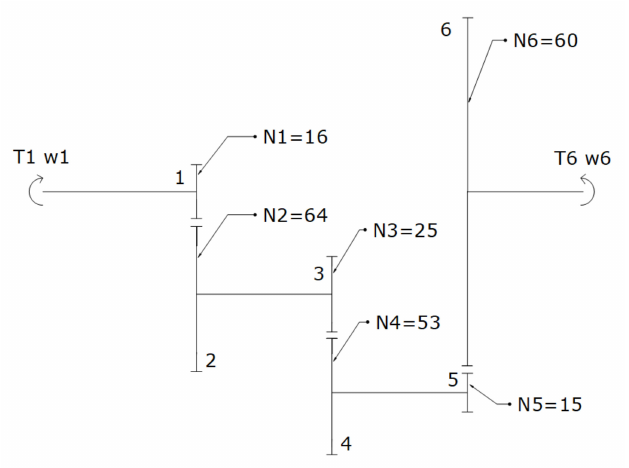
Figure 28. Gear train diagram with indication of the number of teeth